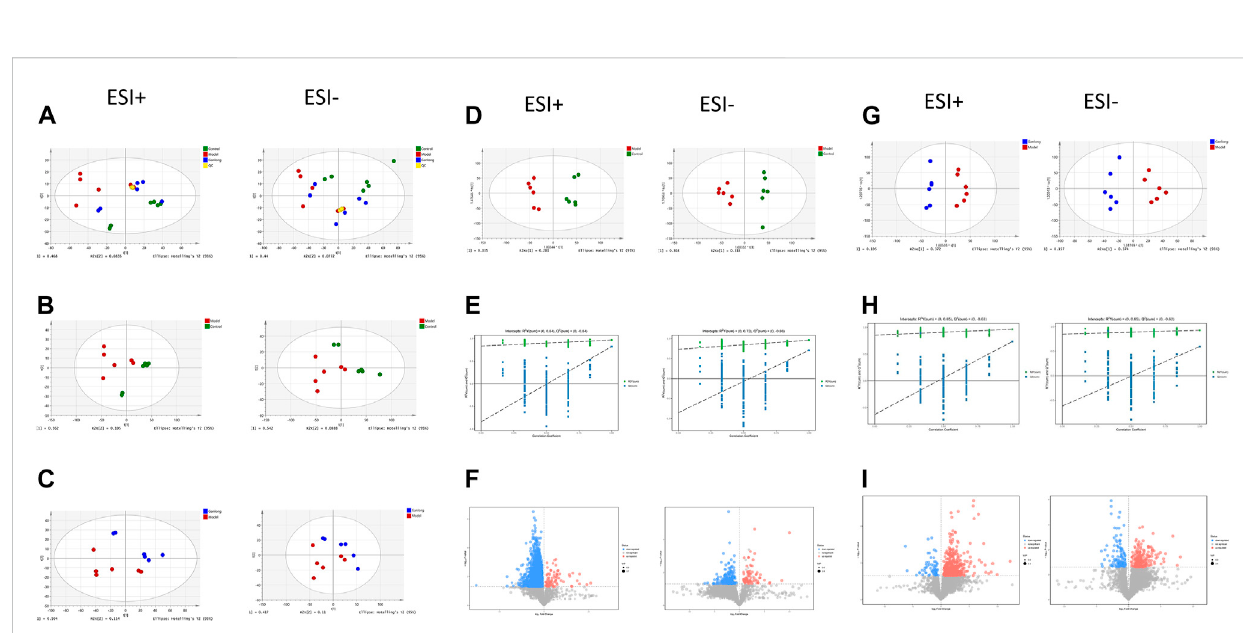
FIGURE 10 Urinarymetabolomicanalysisofganlongcapsuleonliver fi brosisinrats. (A) PlotsoflivertissuePCAscoresbetweenpositiveandnegativeionnormal controlgroup,ganlongcapsulegroupandmodelgrouprats. (B) PCAplotsoflivertissuesbetweenmodelgroupvs.normalcontrolgroupand (C) Ganlong capsule group vs. model group rats in positive and negative ion mode. (D – F) Plots of OPLS-DA scores, 200th response ranking test plots and volcano plots between normal control and model groups in positive and negative ion mode. (G – I) Plots of OPLS-DA scores, 200 response sorting test plots and volcanoes between the model and ganlong capsule groups in positive and negative ion mode. Control group, model group and ganlong capsule treated group ( n = 6).